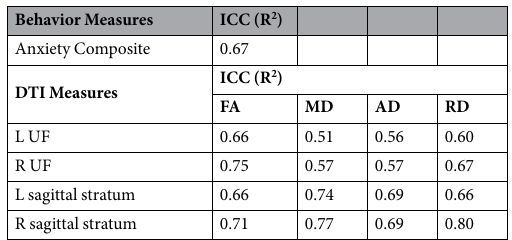
Table 2. Intraclass correlations * illustrating the degree of similarity of MZ twins on behavioral and DTI variables (N = 50 pairs). * All correlations significant at p <